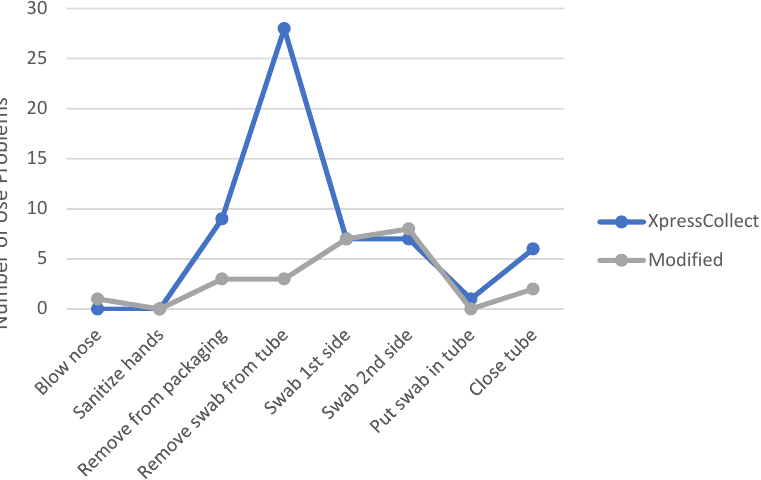
Figure 8. Comparison of observed use problems between XpressCollect and modified swab concept B in Phase 3.